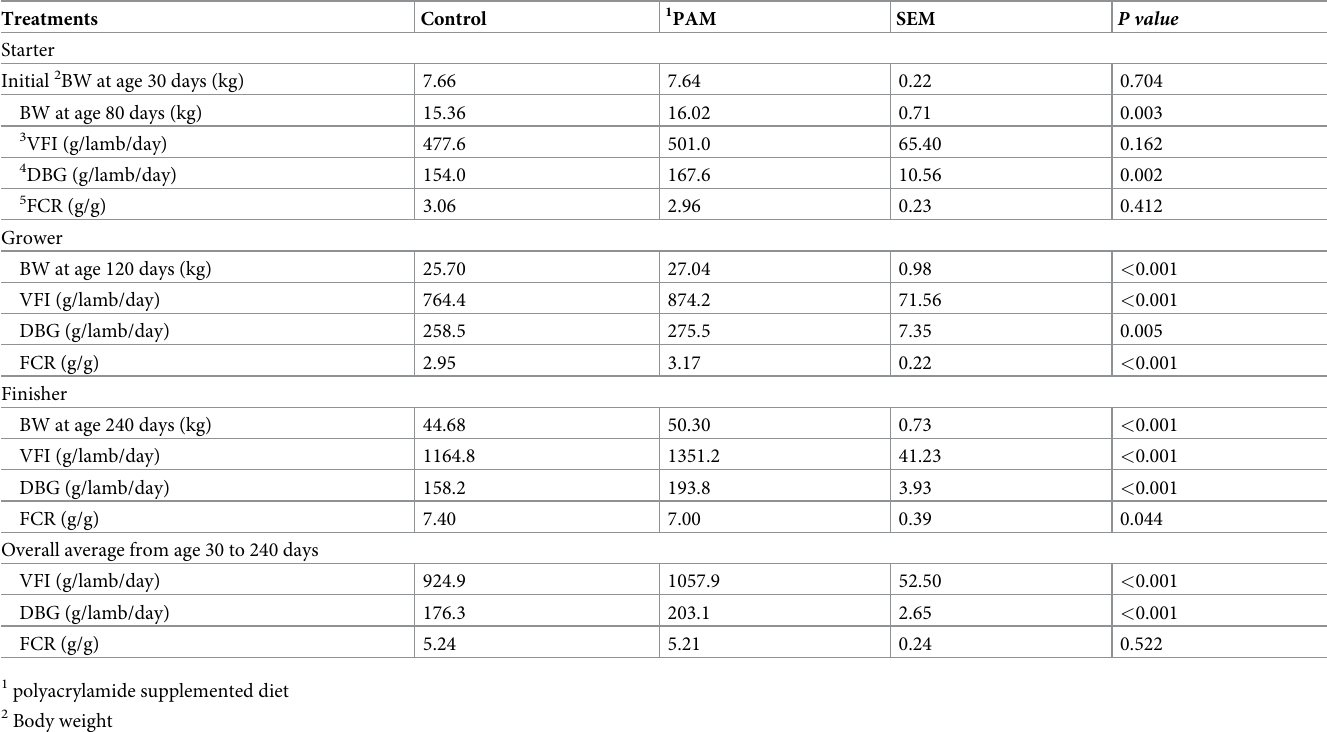
Table 2. The effect of polyacrylamide supplementation on the voluntary feed intake, daily body gain and feed conversion ratio of lambs. Treatments Control 1 PAM SEM P